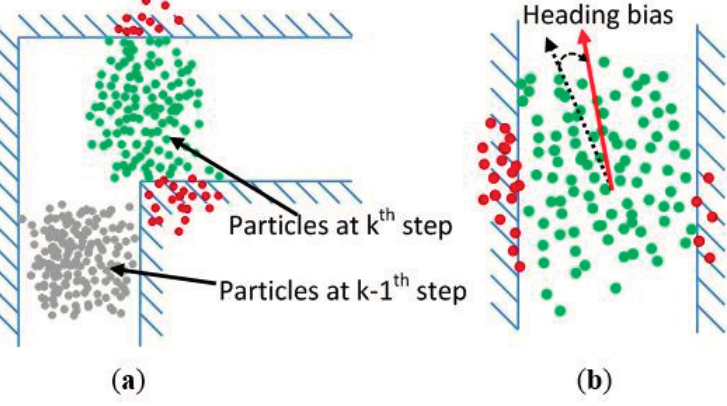
Figure 16. Illustrations of particles status in ( a ) turning situation and ( b ) non-turning situation. Red points indicate dead particles and green points indicate surviving